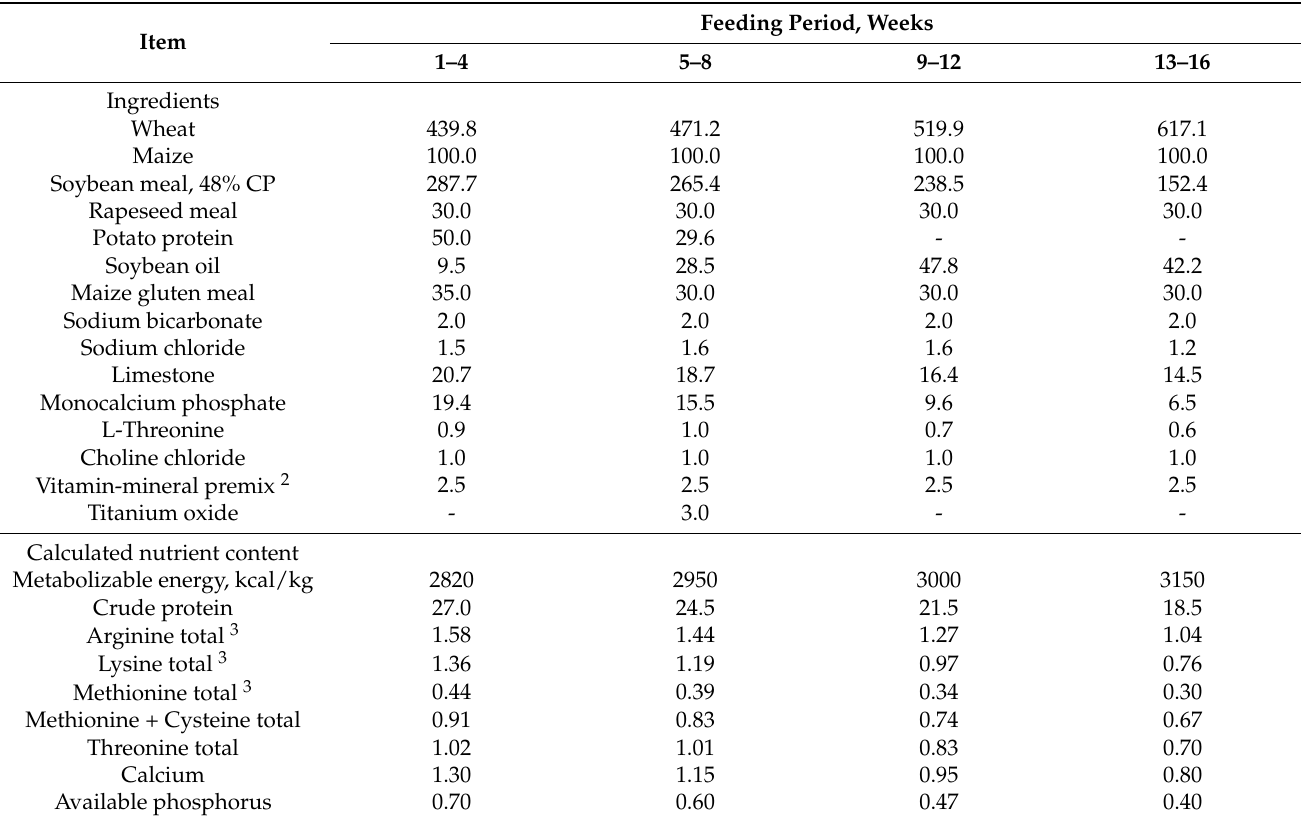
1 Source: This table was published in Poultry Science [3]. 2 Provided per kg diet (feeding periods: weeks 0–4, 5–8, 9–12 and 13–16): mg: retinol 3.78, 3.38, 2.88, and 2.52; cholecalciferol 0.13, 0.12, 0.10, and 0.09; α